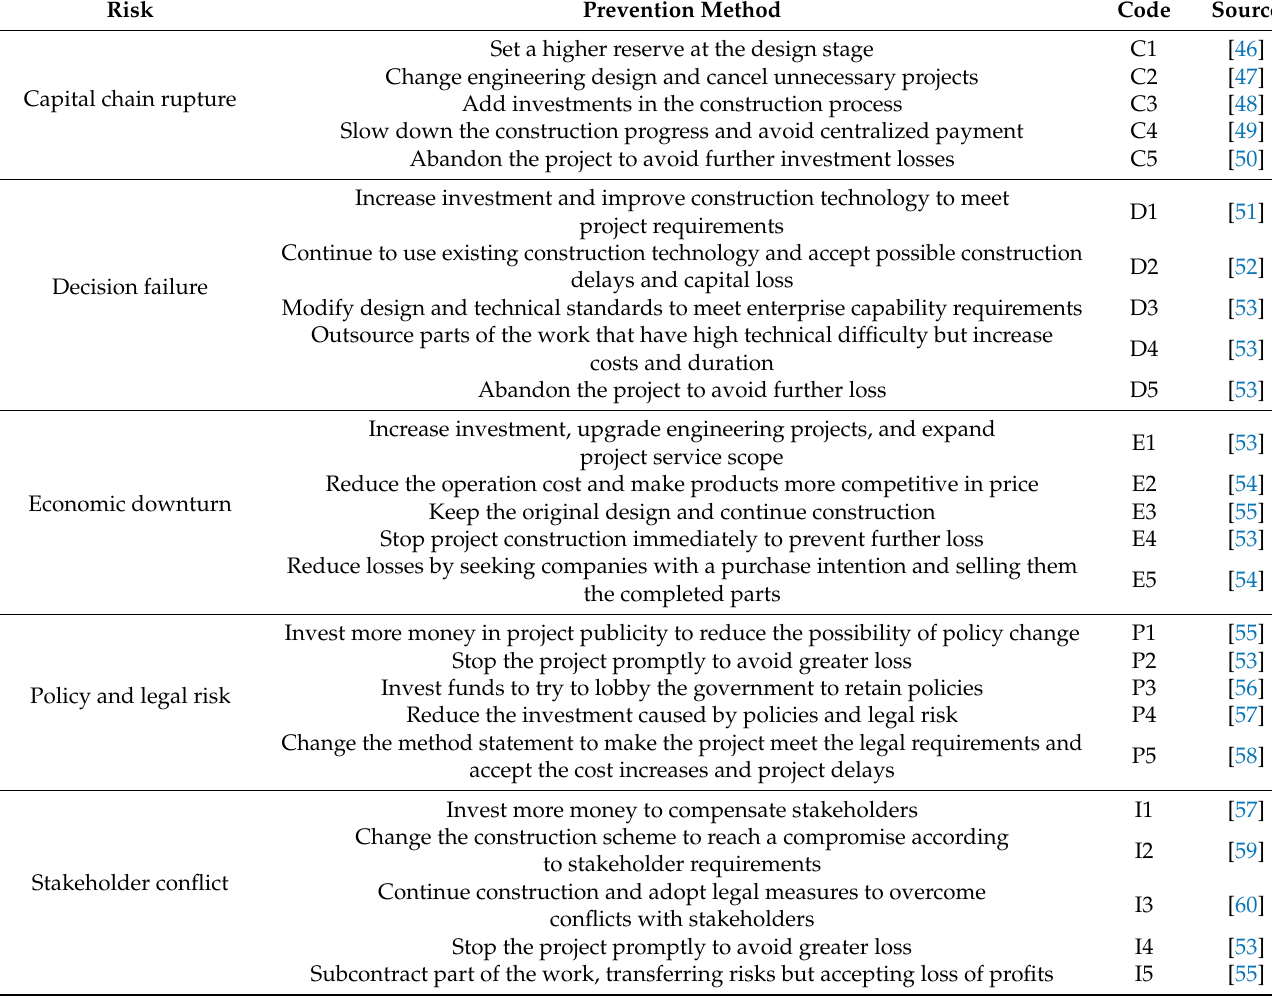
Table 2. The risks prevention methods for gray rhino risks for the Chengdu–Chongqing Middle Line High-speed Railway construction project.